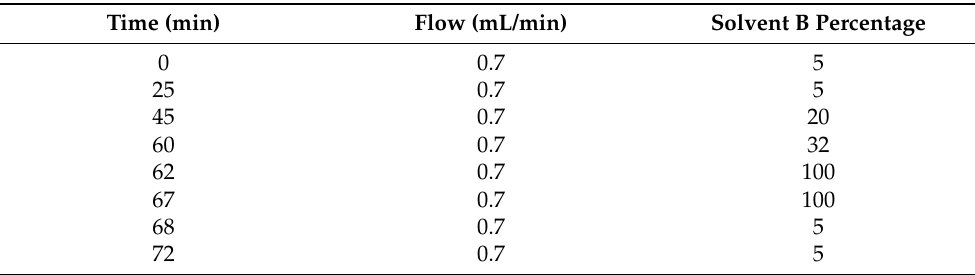
Table 2. Gradient employed to separate fractionation products of proanthocyanidins extracted from cocoa. Time (min) Flow